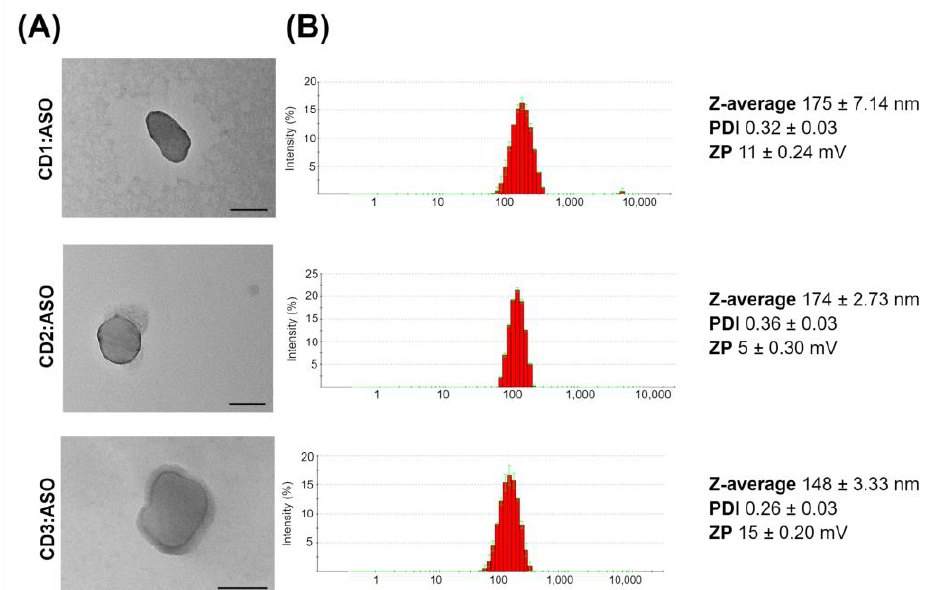
Figure 1. Physicochemical characterization of cyclodextrins (CDs):ASO nanocomplexes. ( A ) Repre- sentative transmission electron microscopy (TEM) of CDs.ASO nanocomplexes. ( B ) Dynamic Light Scattering histogram of the particle size distribution and physicochemical properties. Mean ± S.E.M of 6 technical replicates. All at weight ratio 10:1, 500 nM ASO. PDI: polydispersity index; ZP: zeta potential. Scale bars = 100 nm.